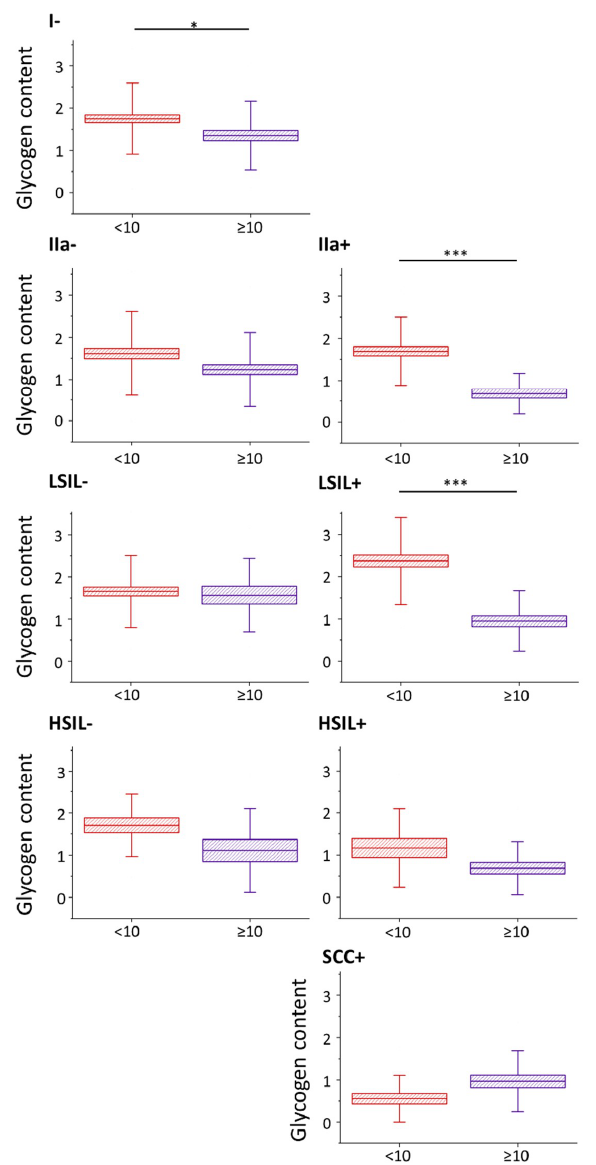
Figure 2. Glycogen content in epithelial cervical cells depending on the nucleus size. The analysis of the glycogen content in the cytoplasm of cervical epithelial cells with cell nuclei of a diameter <10 µm (burgundy color) and ≥10 µm (violet color) based on the integral intensity of the glycogen marker band at 486 cm −1 . Graphs present individual groups of cells: I/HPV − , IIa/HPV − , IIa/HPV + , LSIL/HPV − , LSIL/HPV + , HSIL/HPV − , HSIL/HPV + and SCC/HPV + . Mean values ± SEM are given as box plots: mean (horizontal line), SEM (box), SD (whiskers). * p < 0.05, *** p < 0.001.